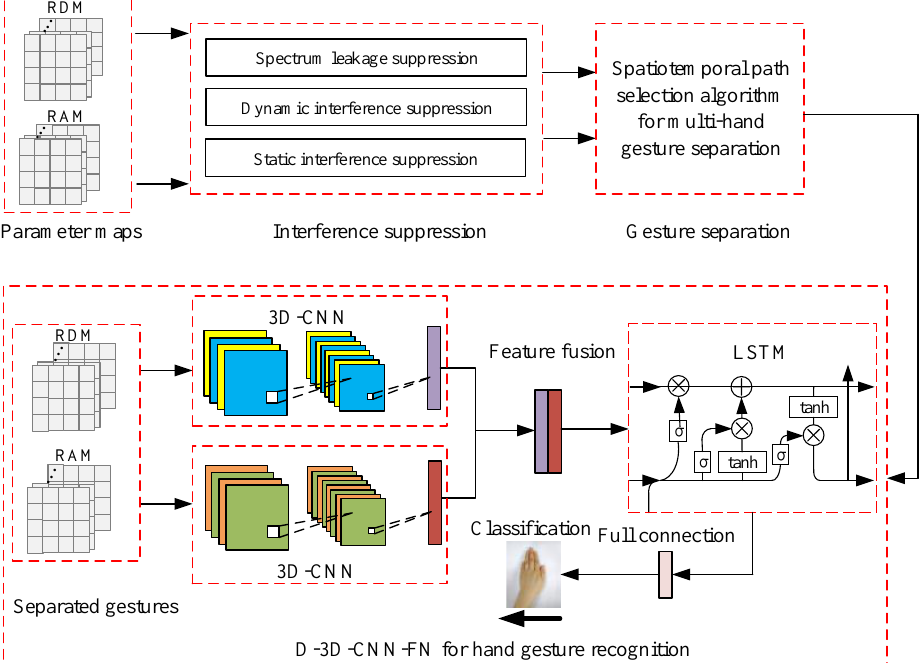
Figure 3. Proposed multi-hand gesture recognition